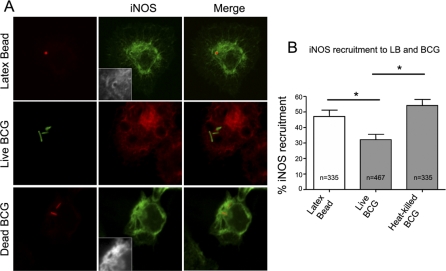
Live Mycobacteria Disrupt Proper Localization of iNOS to the PhagosomeMacrophages were stimulated with IFN-γ and LPS for 16 h and infected with Texas Red–labeled latex beads or M. tuberculosis var. bovis BCG for 10 min. After 1-h chase, cells were fixed, stained for iNOS, and examined by confocal microscopy.(A) Localization of iNOS (green/red) to the phagosome is observed for both latex bead (red) and dead mycobacterial phagosomes (red), but missing from live mycobacterial phagosomes (green).(B) Quantification, using previously reported methods [15] of iNOS localized to phagosomes in cells infected with latex beads, live, or dead mycobacteria. Bars, mean ± s.e.m. (three independent experiments); n, number of phagosomes counted per condition. *
p = 0.0484 (latex bead versus live), 0.0142 (live versus dead).